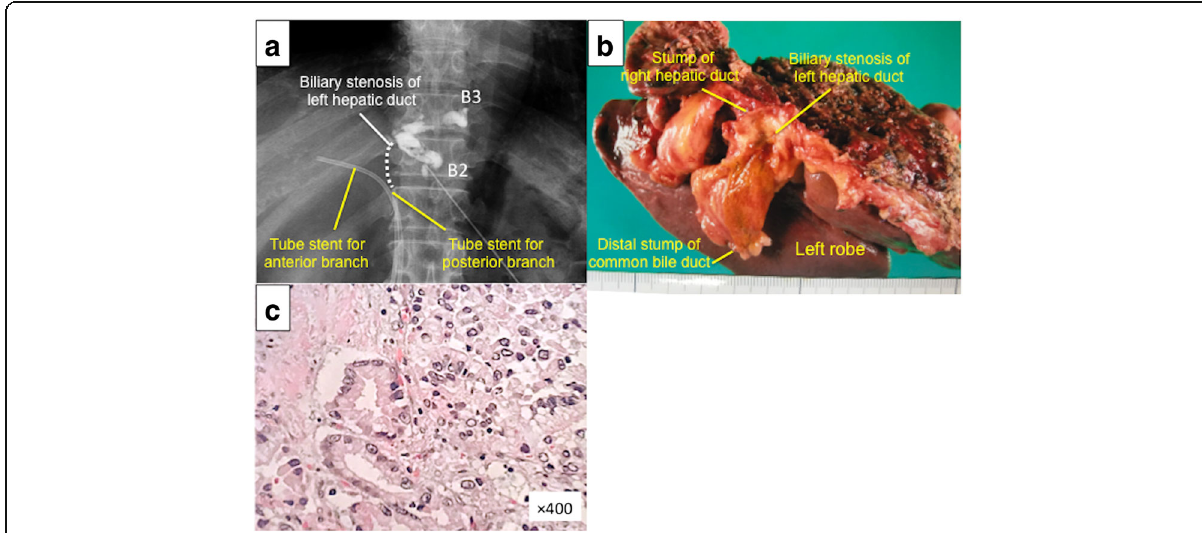
Fig. 1 Initial resection of primary tumor. a Left hepatic duct was obstructed (dotted line), and a biliary stent was placed both in the anterior branch and the posterior branch. b Surgical resected specimen is shown. Stump of the right hepatic duct is free from tumor spreading. c Hematoxylin and eosin staining indicates moderately differentiated tubular